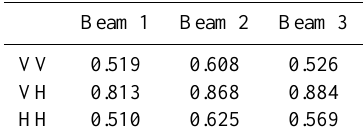
Fig. 13. NRCS (beam 3) at VV (left panels), VH (middle panels), and at HH (right panels) recorded over the AIS during the cycle 98 (4– 11 July 2013), and during ascending orbits (first row) and descending orbits (second row). Grid cells where the land fraction was less than 0.25 were masked. Table 1. Linear correlation coefficients of the weekly gridded NRCS observations made during the ascending and descending or- bits over the AIS during the first week of July 2013 (cycle 38